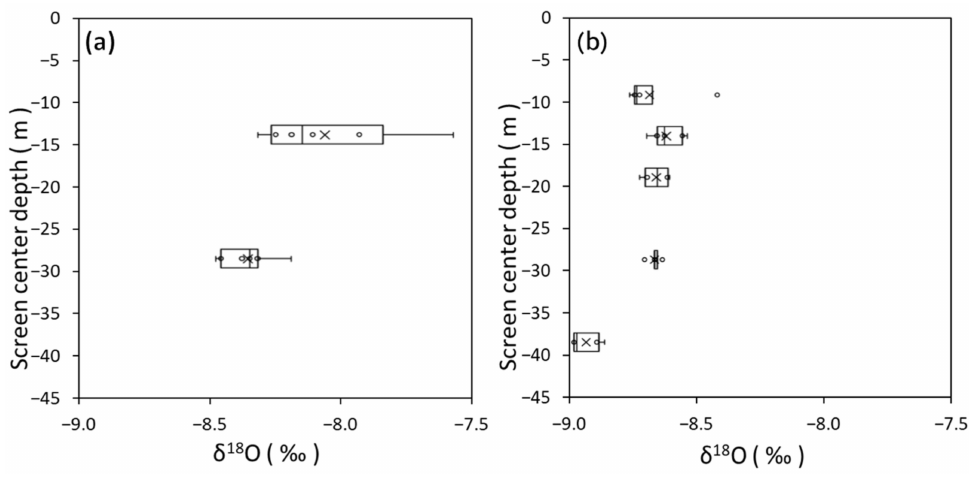
Figure 3. δ 18 O variations in groundwater at different depths: ( a ) G8 and ( b )